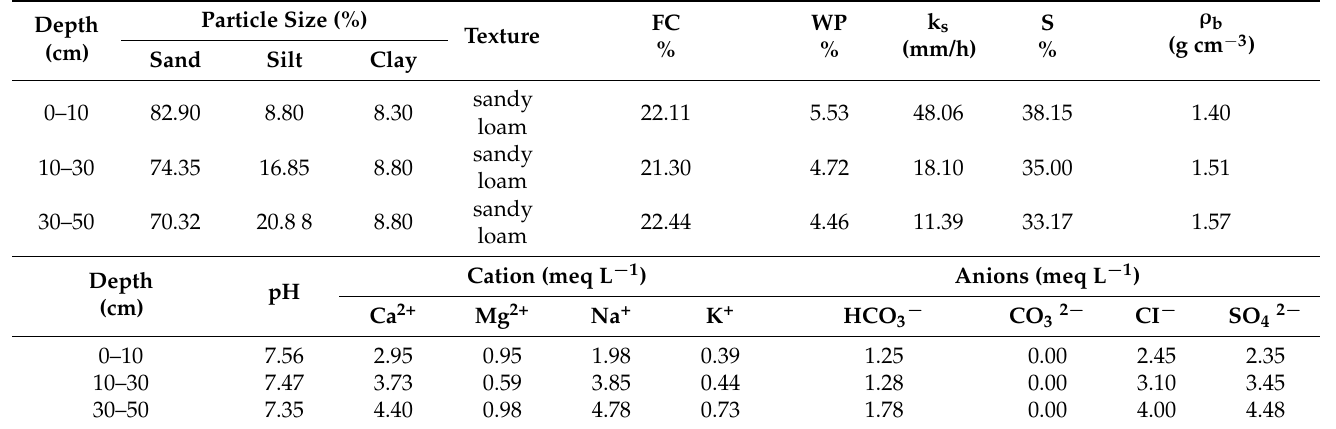
Table 1. Soil physical and chemical